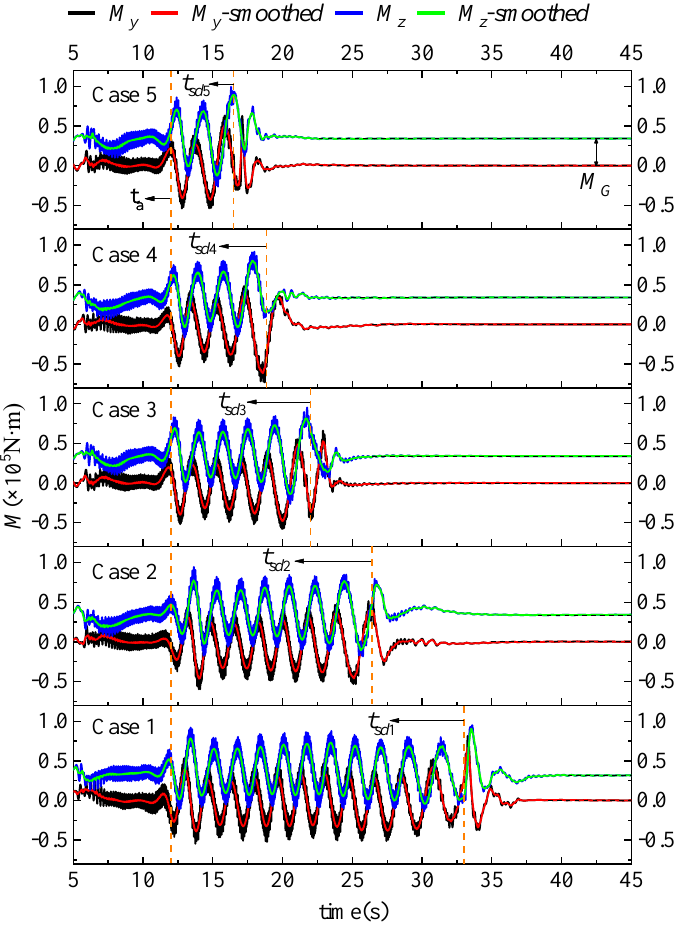
Figure 8. The moment in the y direction and z direction in the five cases. Table 2. Performance matrix of typical parameters in the five cases.